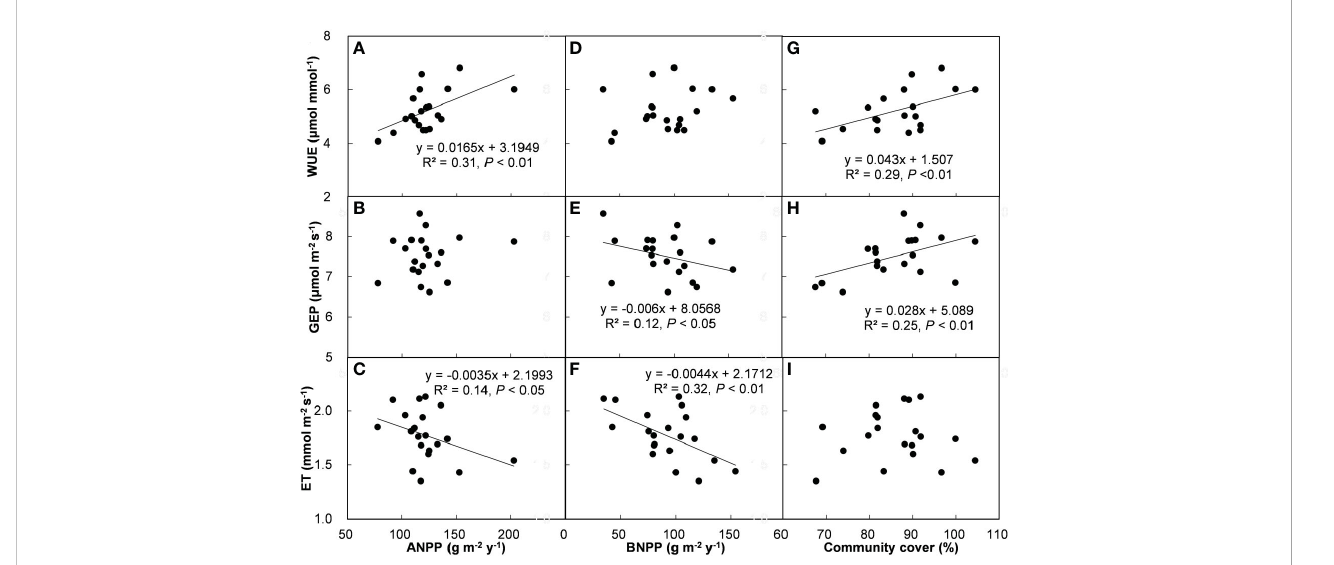
FIGURE 6 Relationships of WUE, GEP, and ET with ANPP (A – C) , BNPP (D – F) , and community cover (G – I)